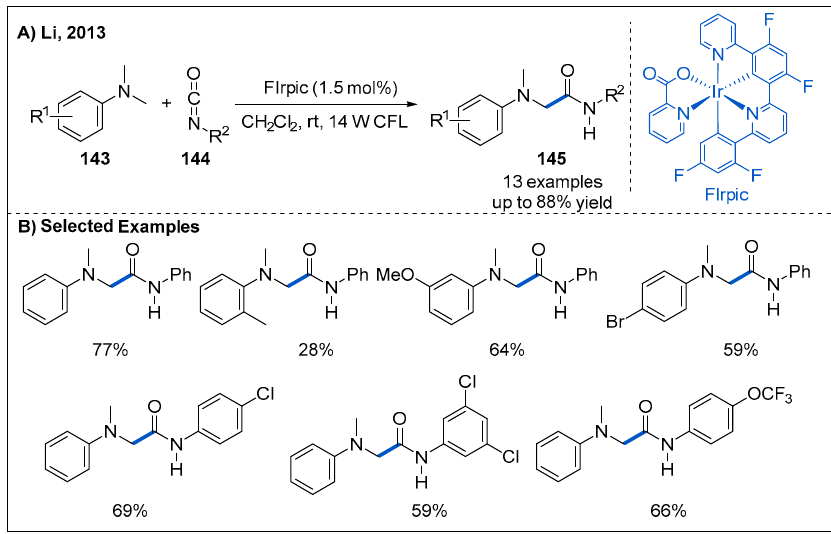
Figure 43. Visible-light-driven photoredox-catalyzed amide synthesis from isocyanates and N , N - dimethylaniline derivatives.